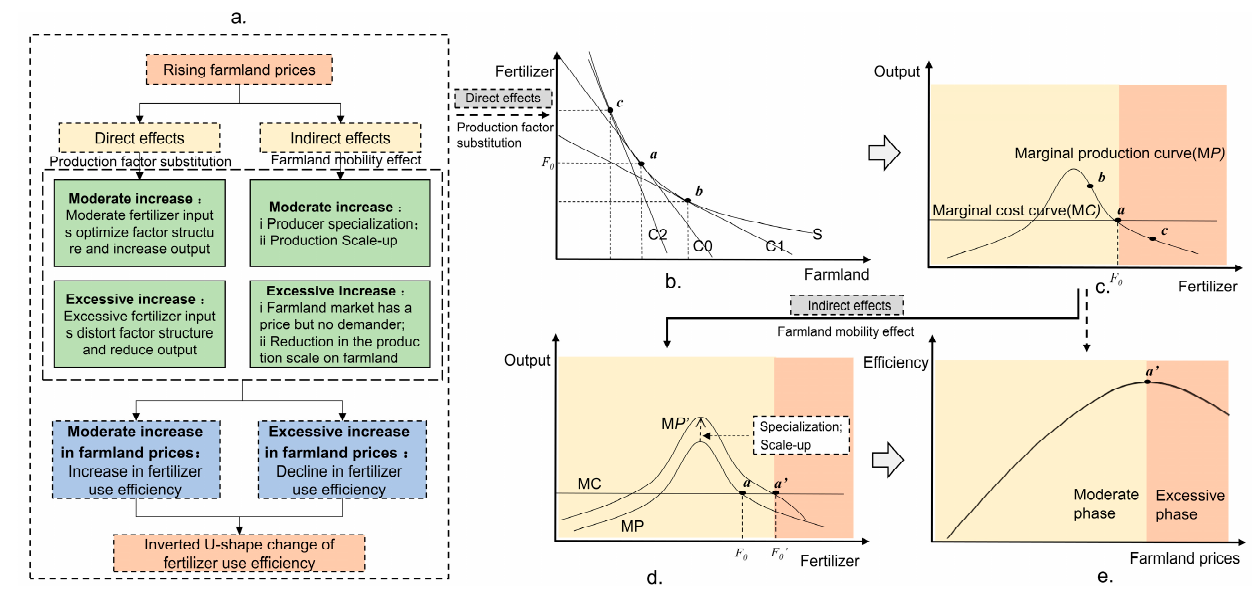
Figure 1. Mechanisms of the impact of rising farmland costs on fertilizer use efficiency. ( a ) illustrates the path of the impact of rising farmland costs on fertilizer use efficiency. ( b ) illustrates the substitution of fertilizers on farmland. ( c ) illustrates the effect of fertilizer input quantity on farmland output. ( d ) illustrates the effect of fertilizer input quantity on farmland output under the effect of indirect pathways. ( e ) illustrates the relationship between rising farmland costs and fertilizer use efficiency.